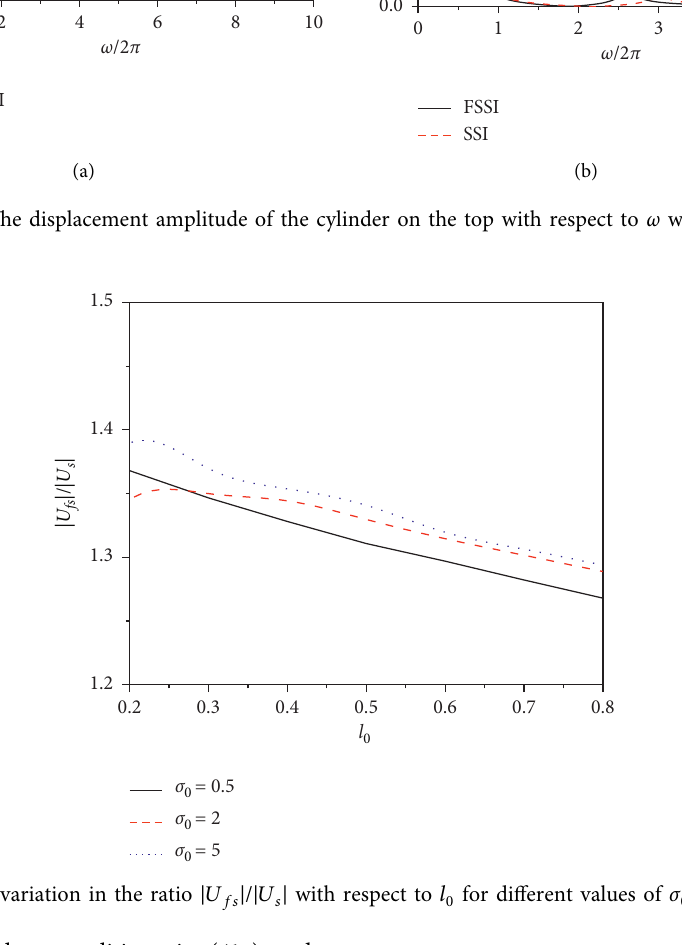
for different values of σ 0